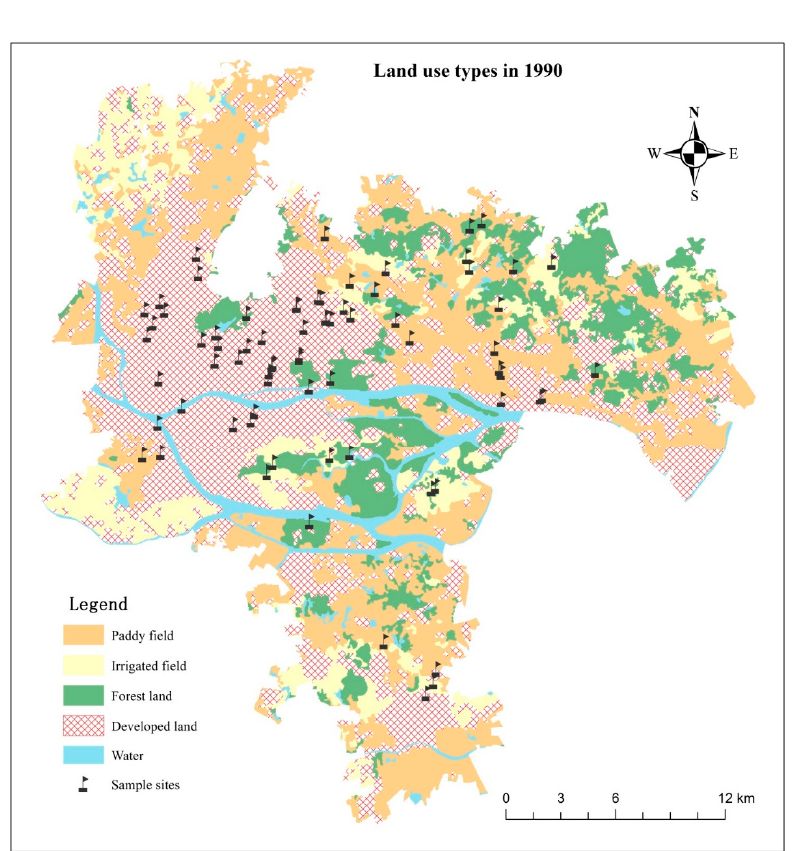
Figure 3. Land use types of sample plots in the study area in 1990.